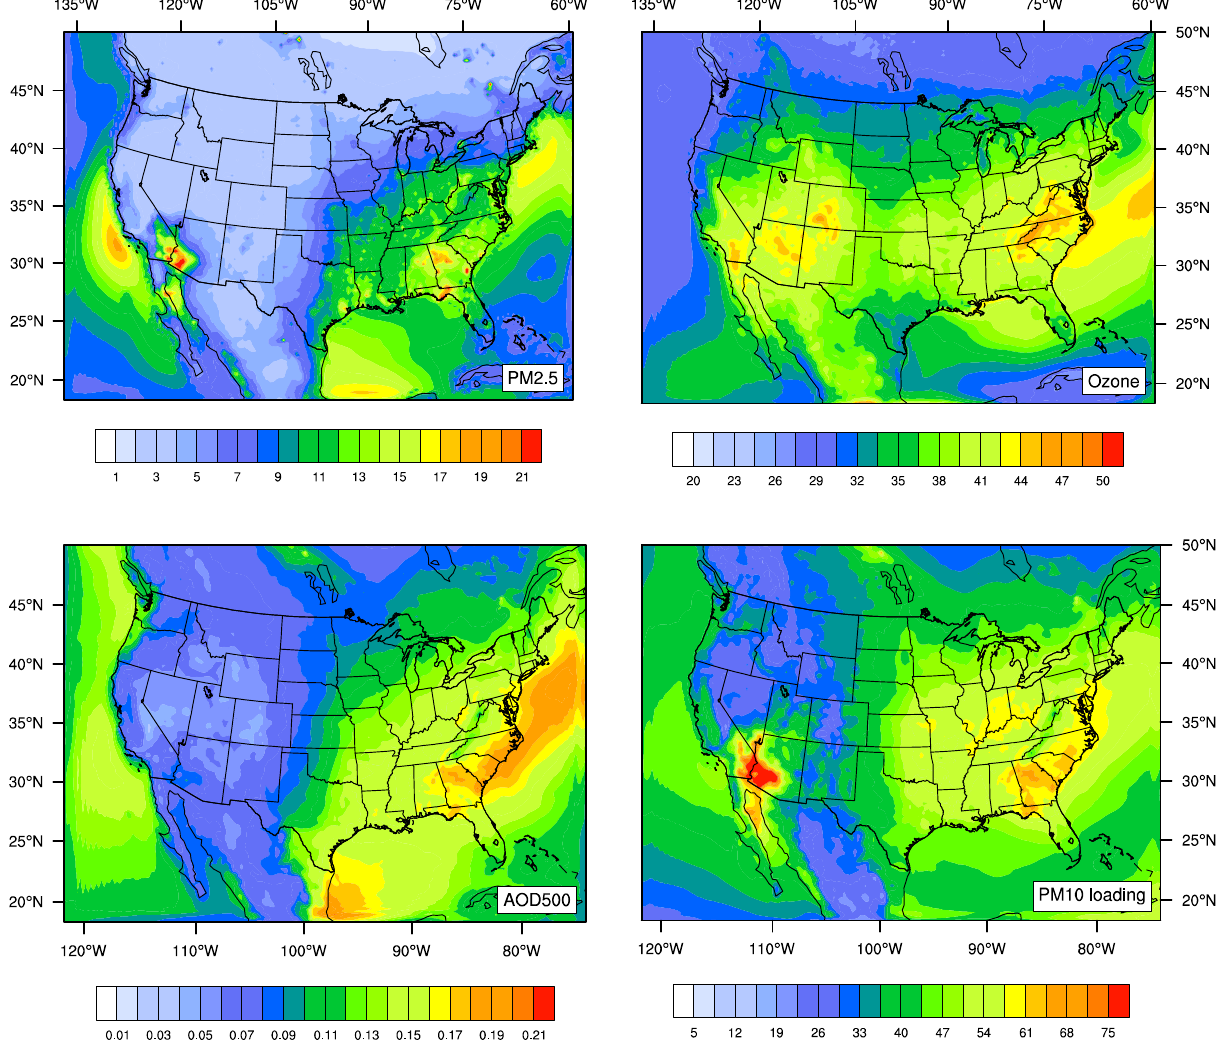
Figure 2. Spatial distributions of the three-month average surface PM2.5 ( μ g·m − 3 ), ozone (ppbv), AOD at 500 nm, and PM10 loading (mg·m − 2 ) from the experiment